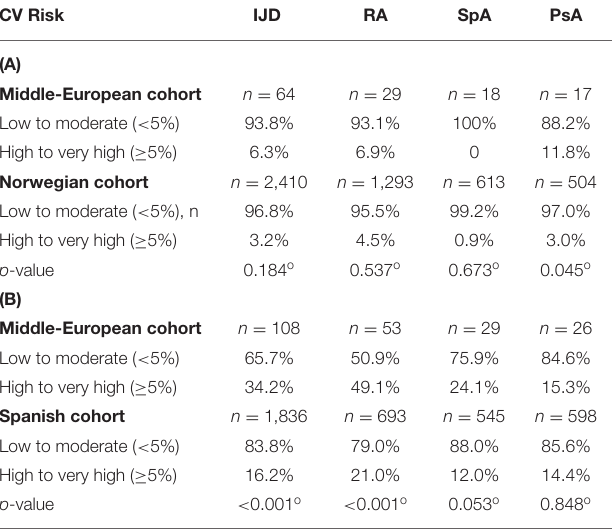
TABLE 5 | Cardiovascular risk in patients with IJD (A) without CV disease, diabetes mellitus, lipid-lowering or antihypertensive therapy between the age of 30 and 80 years according to the Norwegian approach (data based only on SCORE values) and in patients with IJD (B) without CV disease older than 40 years according to the Spanish approach (original 2003 SCORE was used).